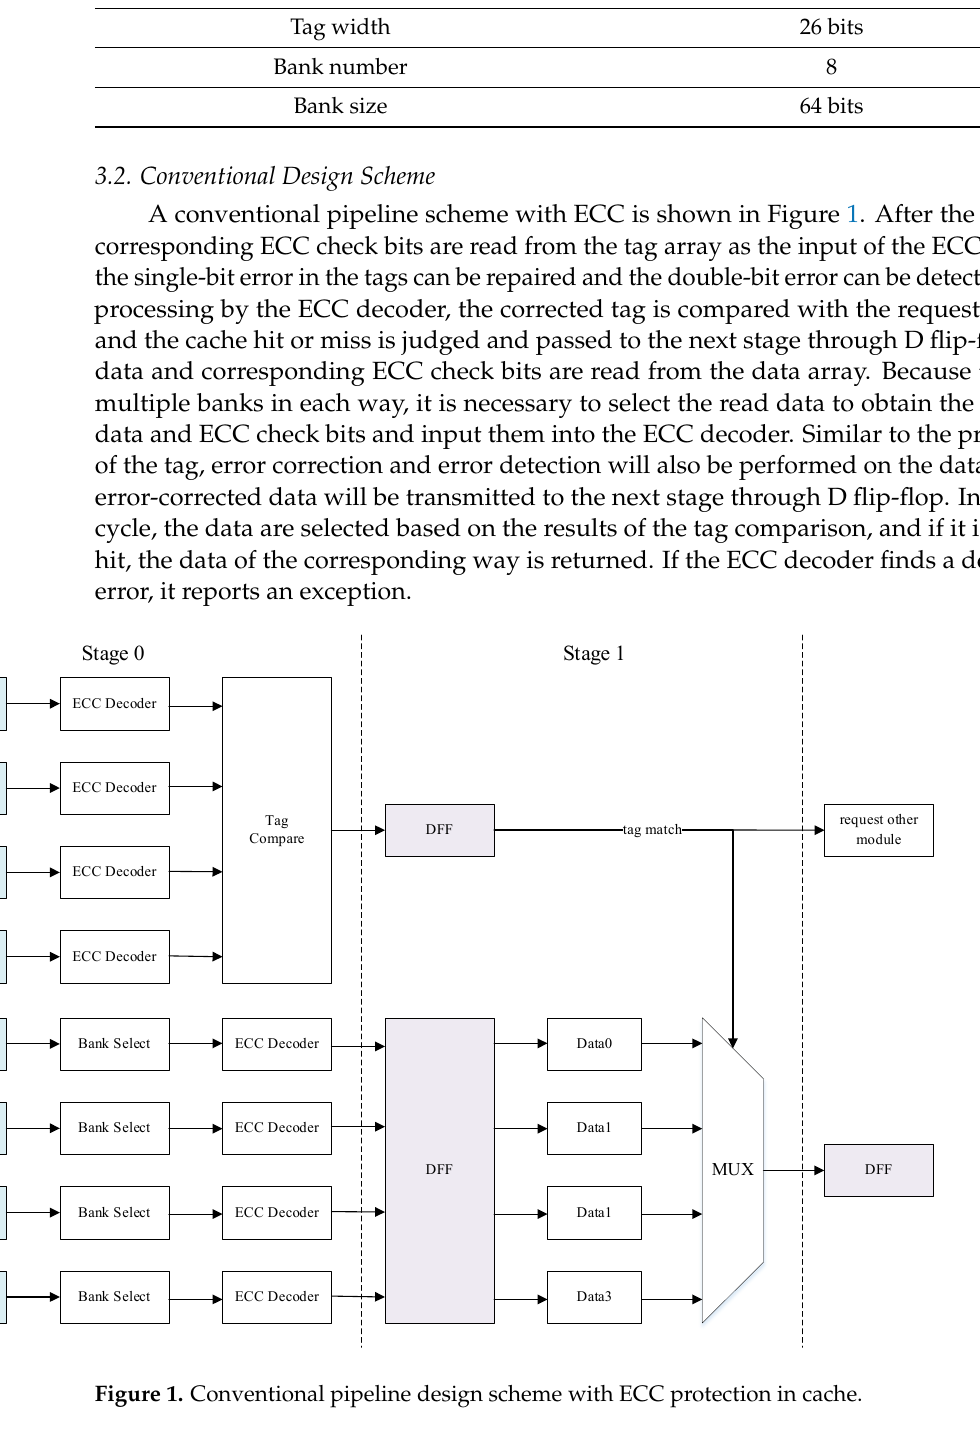
Table 1. Cache parameter and configuration.